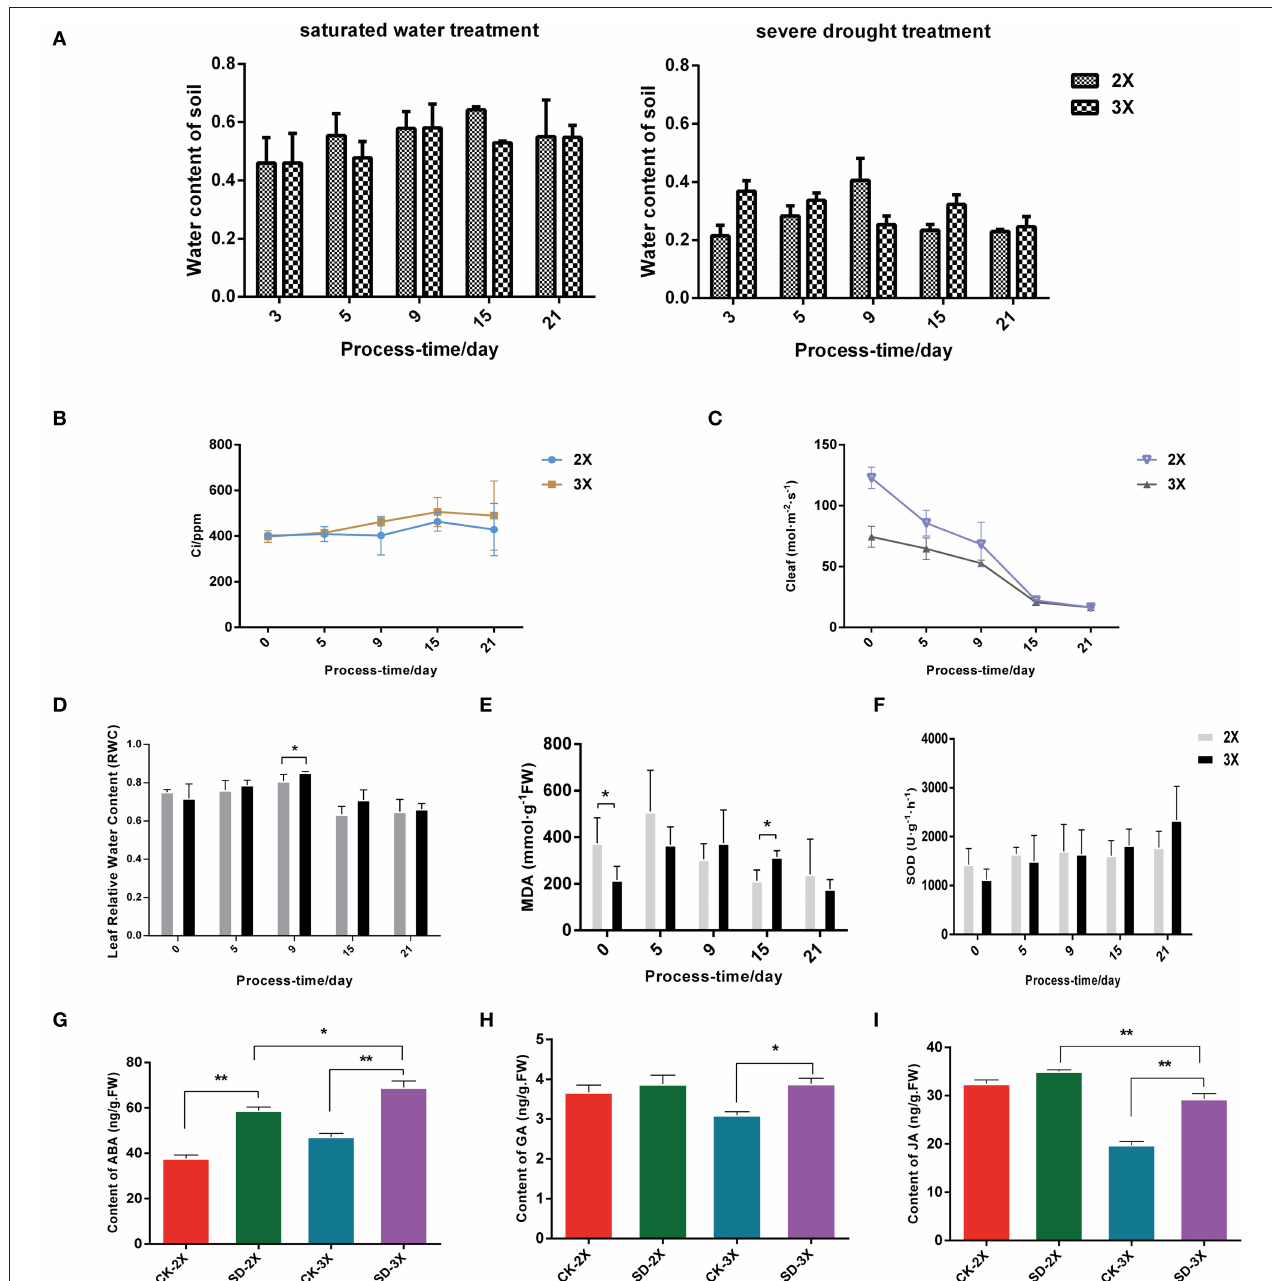
FIGURE 1 | Physiological parameters in diploid (2X) and autotriploid (3X) subjected to different days of drought stress. (A) Water content of soil; (B) Ci: Intercellular CO2 concentration; (C) Cleaf: stomatic conductance; (D) Leaf relative water content; (E) MDA: malonaldehyde; (F) SOD: superoxide dismutase. (G-I) Hormonal content in leaves of diploid and triploid with drought stress for 9 days for ABA (G) , GA (H) and JA (I) . All assays were carried out at least three times and statistical significance levels were calculated using Student’s t -test (* P ≤ 0.05; ** P ≤ 0.01). CK, control; SD, severe